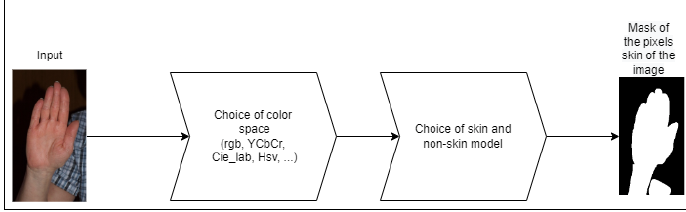
Figure 5. Conceptual diagram of the skin segmentation process.